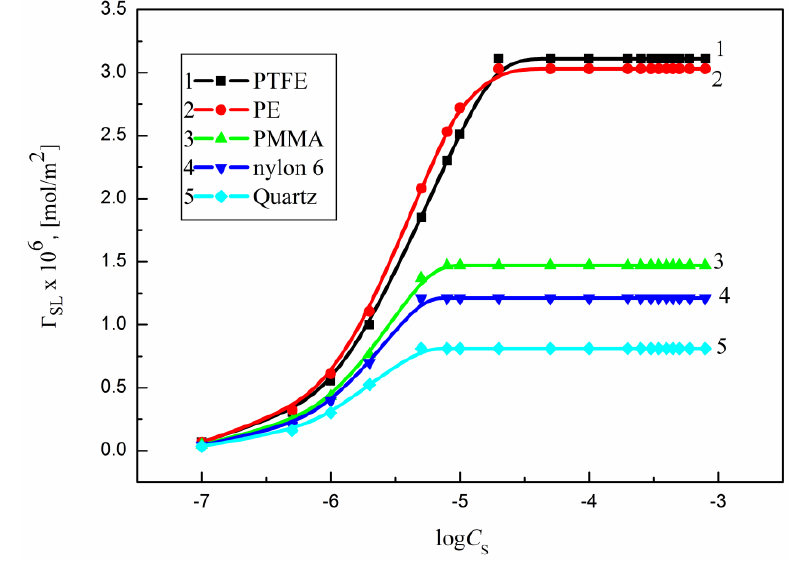
Figure 10. A plot of the SML Gibbs surface excess concentration ( Γ SL ) (curves 1–5) at the PTFE, PE, PMMA, nylon 6 or quartz–water interfaces, respectively, vs. the logarithm of SML concentration (log C S ).